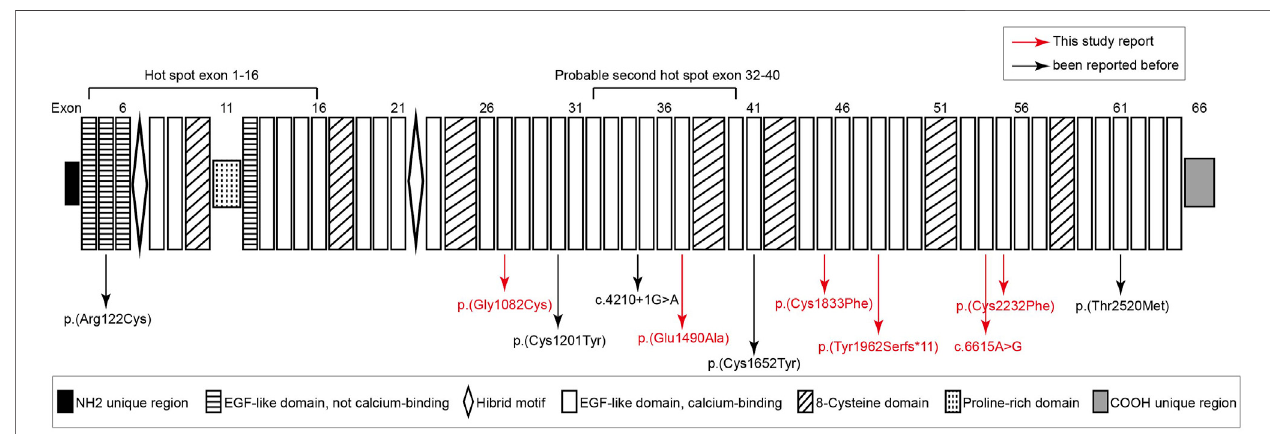
FIGURE 1 | Structure diagram of FBN1 sequence, and distribution of FBN1 mutations identi fi ed from Marfan syndrome patients. six variants marked in red are novel variants never reported before. Except for a splicing variant (c.4210+1G > A) and c.364C > T [ p (Arg122Cys)] that occurred in the not calcium binding EGF-like domain, other variants all occurred in the calcium binding EGF-like domain and four mutations happened in the cysteine residues of FBN1 .